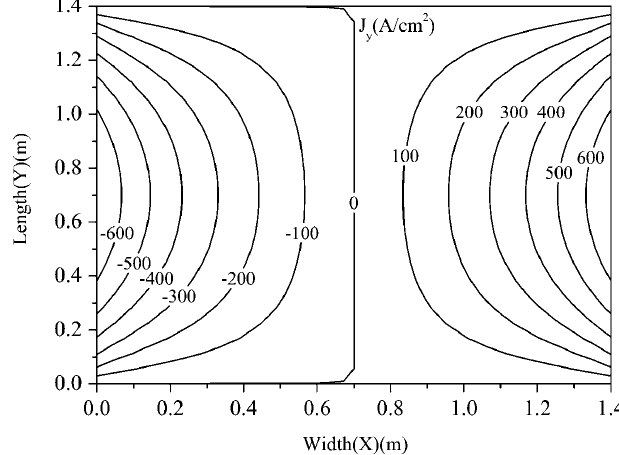
FIG. 8. Contour plot of Y component of the eddy current , in the aluminum plate of dimension ð 1 : 4 ; 1 : 4 ; density, j y 0 : 002 Þ m 3 when exposed to a field exponentially decaying with time.